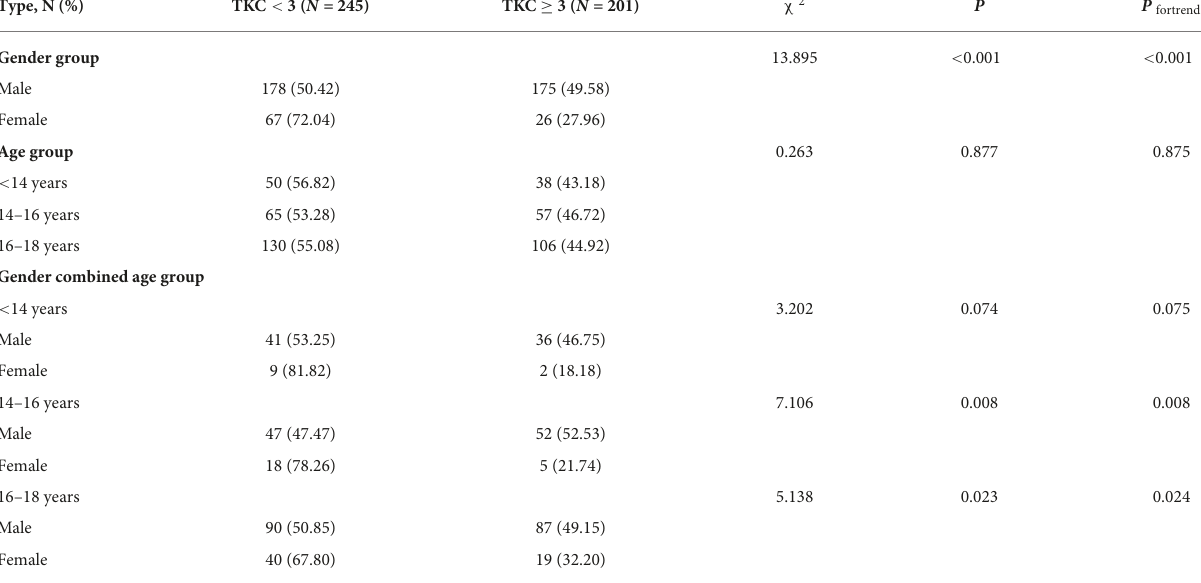
TABLE 4 Distribution of keratoconus severity according to gender and age